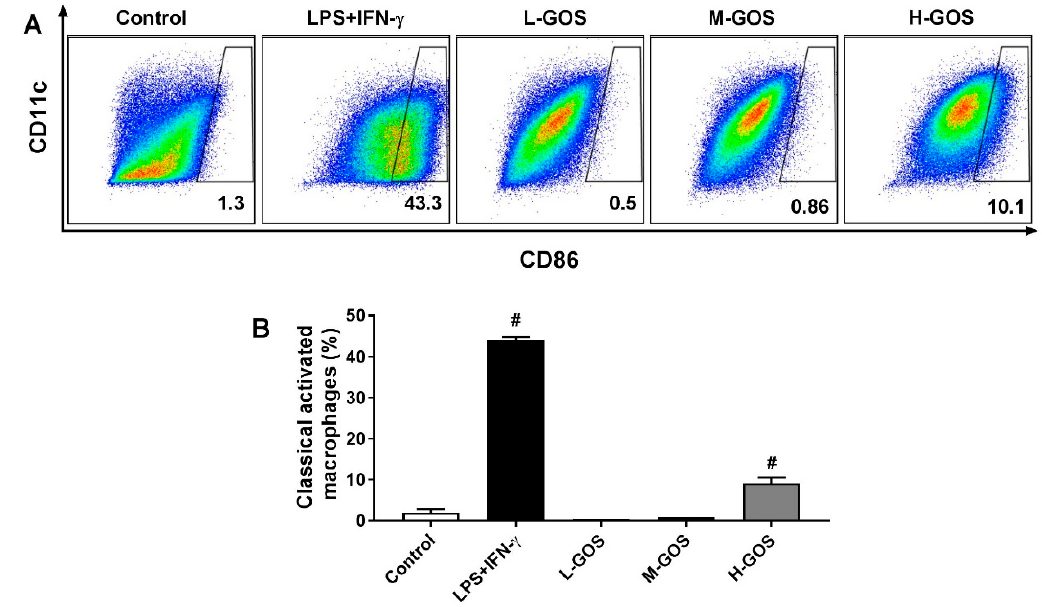
Figure 2. Effects of GOS on polarization of BMDMs. Expression of CD11c and CD86 on BMDMs cell surface ( A ) and accordingly the percentage of M1 phenotype macrophages ( B ) after GOS (25 − 100 µ g / mL) treatment was analyzed by flow cytometry. # —Indicated significant difference versus the control group at p < 0.05.